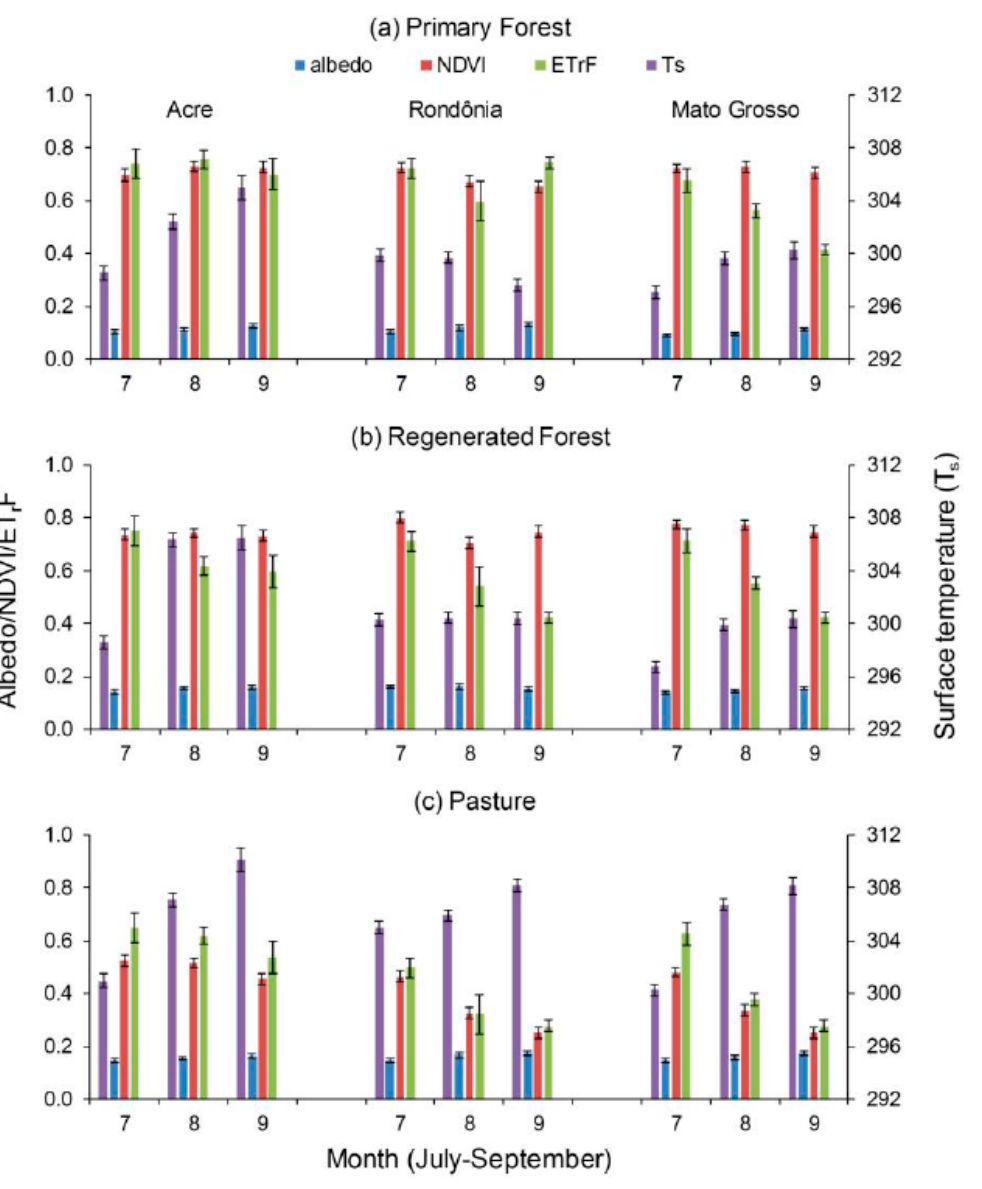
Figure 6. Variation of surface temperature, albedo, NDVI, and ET r F from primary forests, regenerated forests, and pasture during the dry season in 2009 in the study sites. Variations in monthly ET rates estimated by METRIC 2 for different land cover types during the 2009 dry season are illustrated in Figure 7. Among the three study sites, Mato Grosso showed the lowest ET rates from all land cover types in Mato Grosso (Figures 7 and 8 and Table 5) compared to Rondônia and Acre.